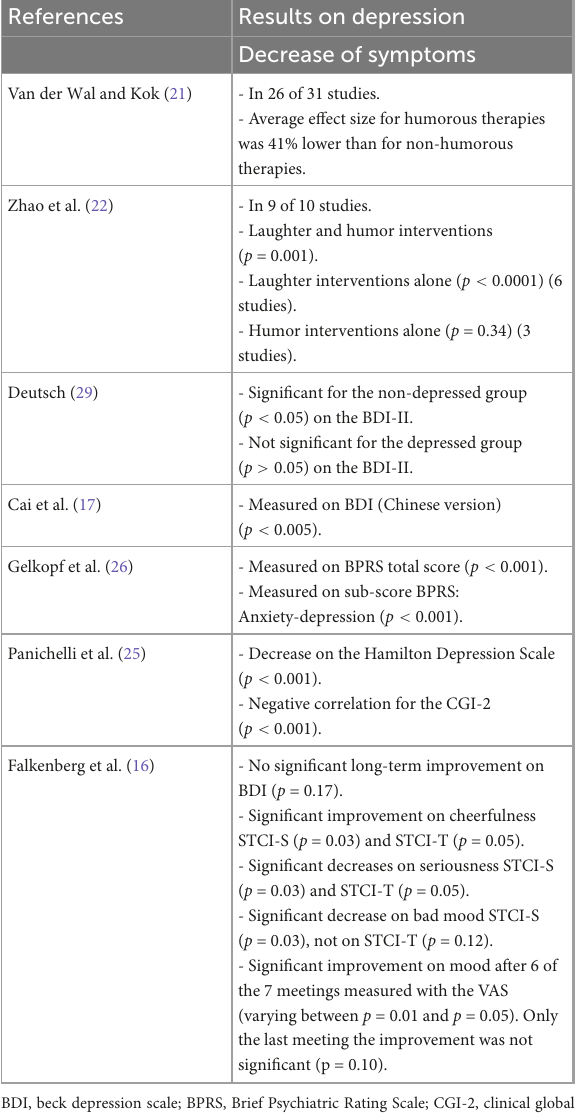
TABLE 3 Results on depression